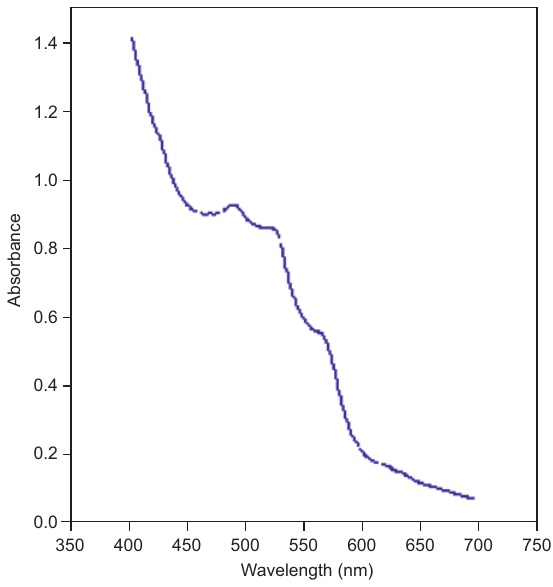
Figure 3 Spectrum obtained from the extract of the roots of O. nigricaule